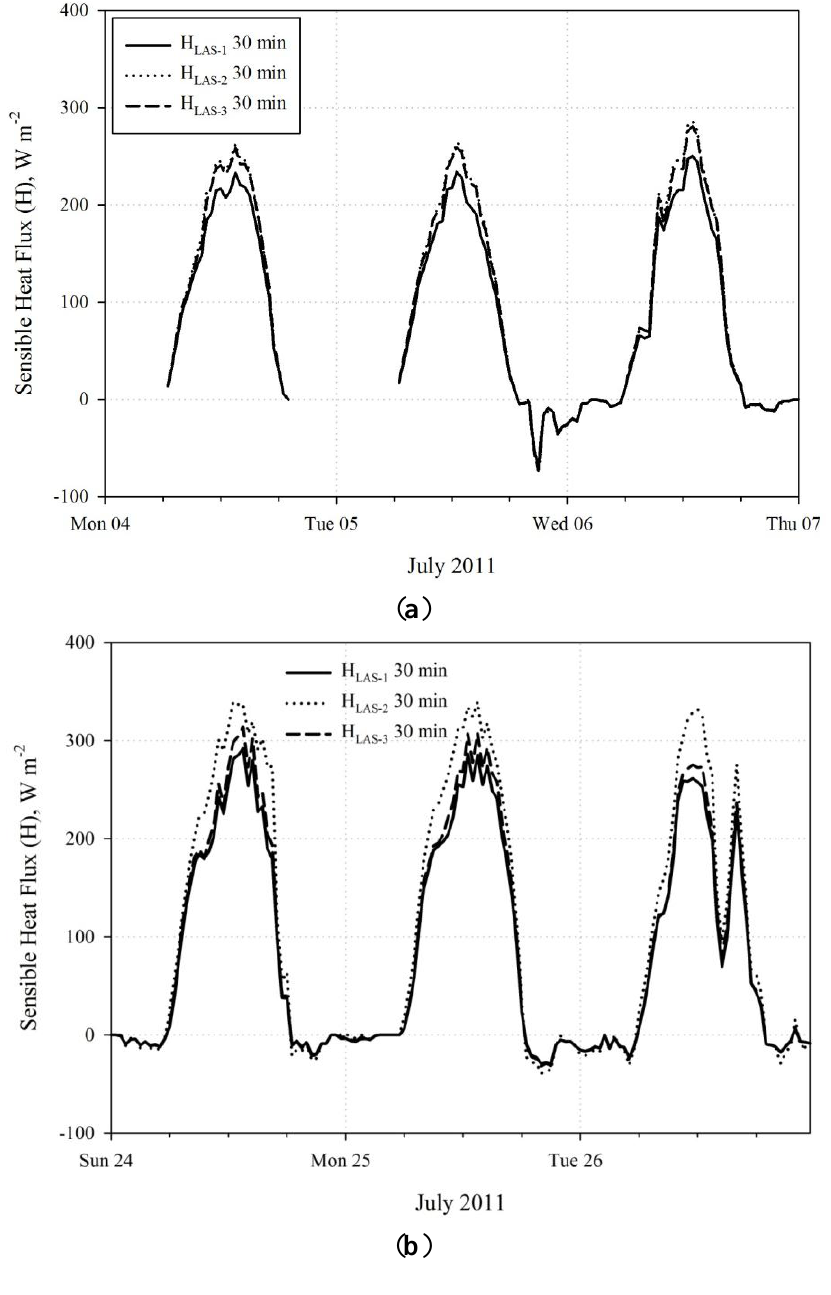
Figure 5. Time series plots of sensible heat flux ( H , W·m −2 ) for LAS-1, LAS-2, and LAS-3 for data subsets from 4–6 July, representing good LAS alignment ( a ) and 24–26 July, representing poor alignment in LAS-2 and good alignment in LAS-1 and LAS-3 ( b ). Figure 5a represents data shown in Figure 4a,b. Figure 5b represents data shown in Figure